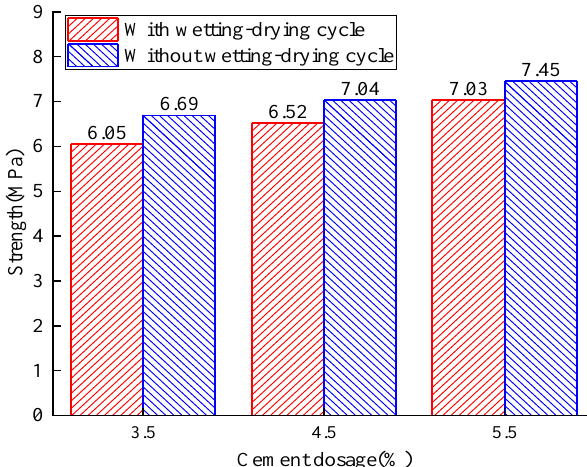
Figure 21. Analysis of the water-stability test.